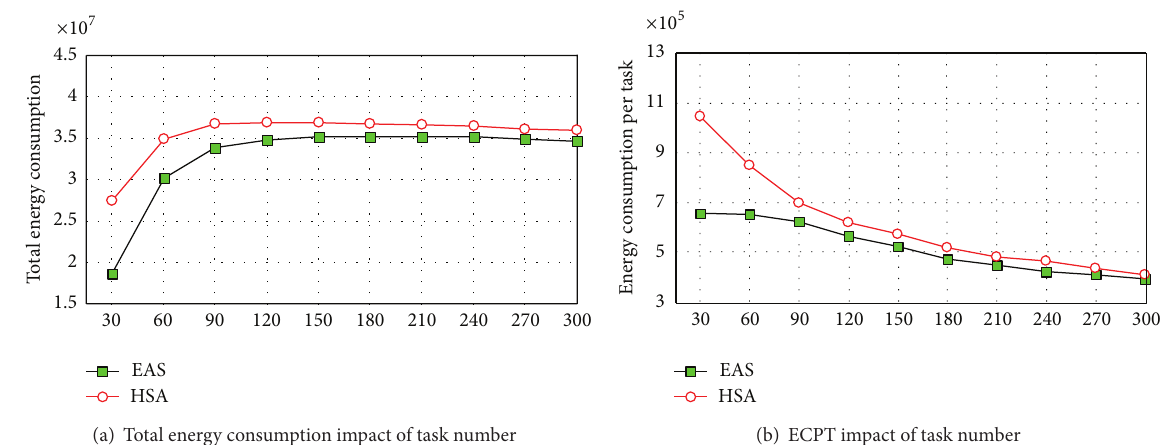
Figure 4: The scheduling results of EAS